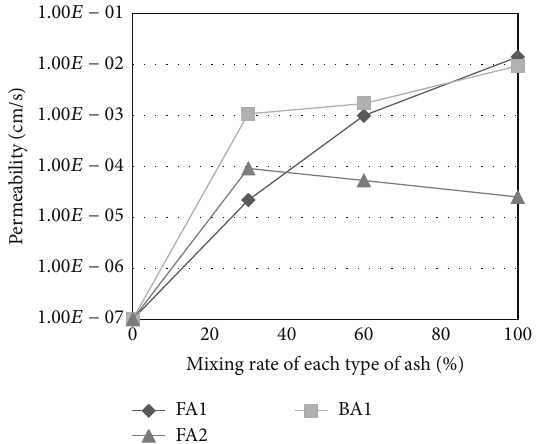
Figure 7: Permeability of the simulated topsoil mixed with the coal ash at the mixing ratio of 0%, 30%, 60%, and 100%.